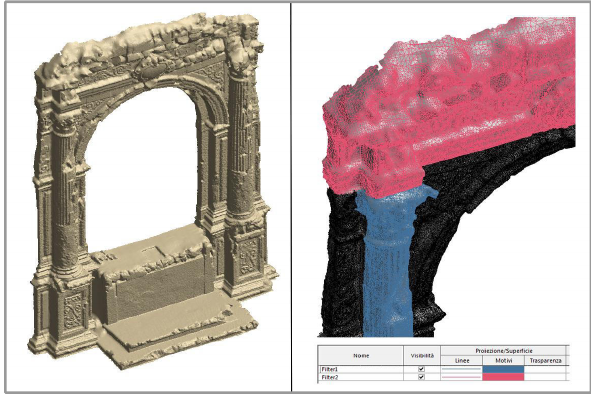
Figure 15 The creation of a nested family and the application of filters in BIM environment